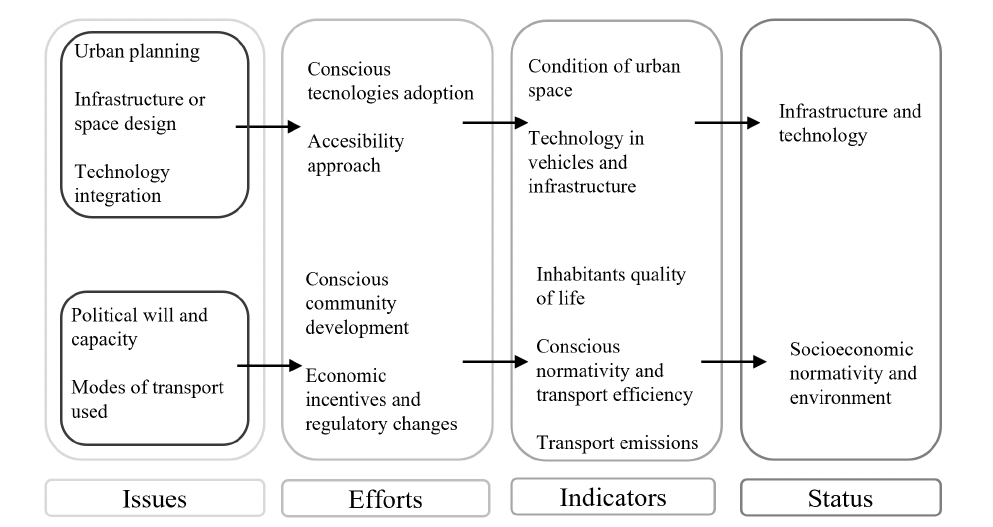
Figure 3. Analysis workflow of conscious mobility case